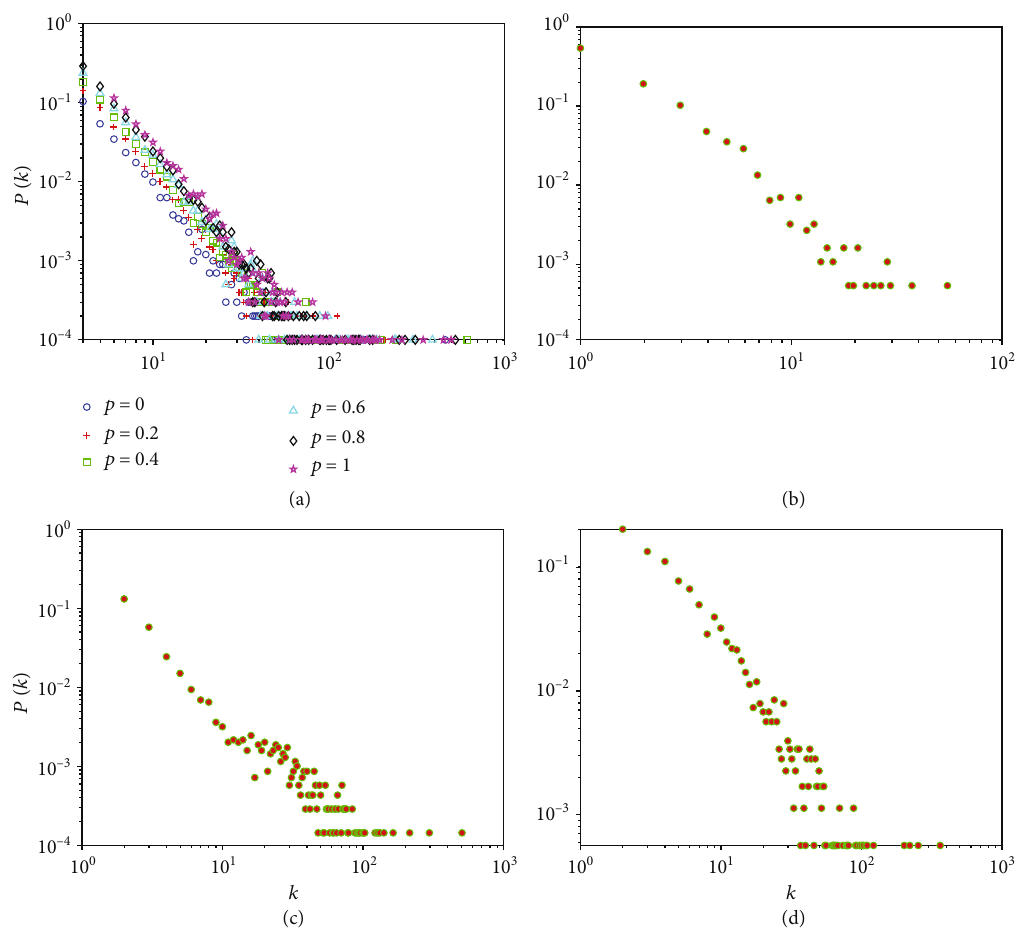
Figure 3: Power law distribution of network: (a) distribution of simulation data ( m = 2 ) and power law exponent value α = − 3 ; (b) data from the yeast protein network [48], α = − 2 : 87 ; (c) Erd ő s network [49], α = − 3 : 228 ; (d) bible vocabulary network [50], α = − 1 : 907